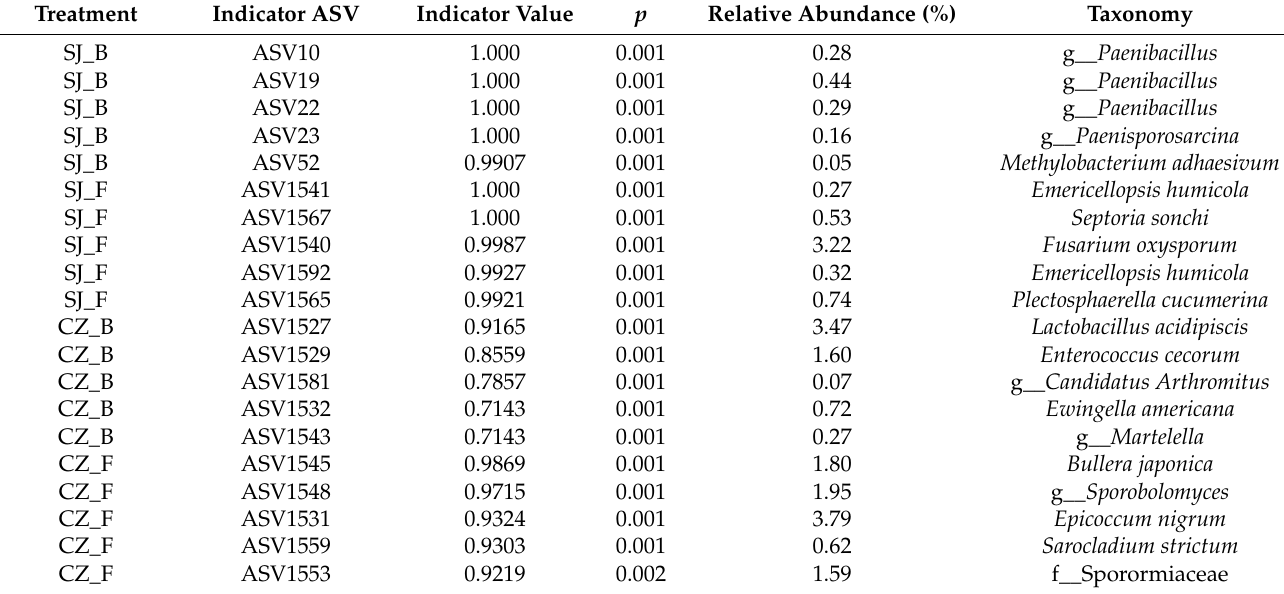
Table 4. Intestinal bacterial and fungal indicator species of Hooded Crane of the lake groups between Shengjin and Caizi Lakes. The top five indicator taxa according to the indicated value were listed (except for indicator value < 0.6). f: family g: genus. SJ: Shengjin Lake; CZ: Caizi Lake; B: bacteria; F: fungus.